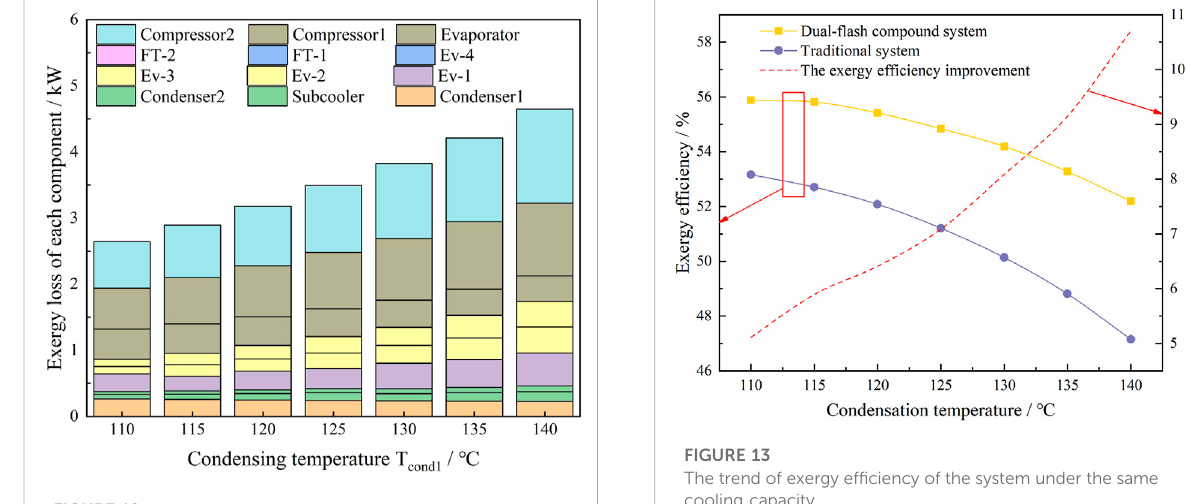
FIGURE 12 The exergy loss of each component of the system with the condensing temperature under the same heating capacity.